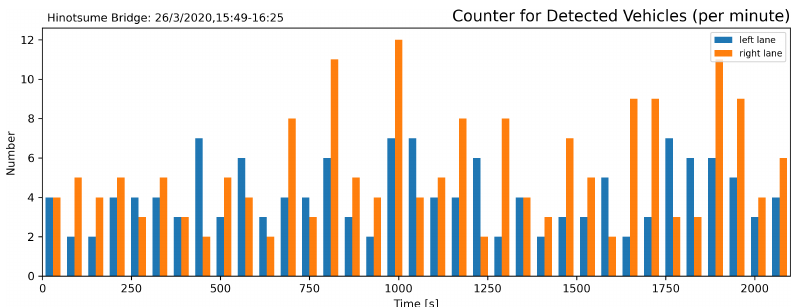
Figure 10. Traffic count in a one-minute segment. Traffic was calm with an average of 4.13 vehi- cle/min eastbound and 3.25 vehicle/min